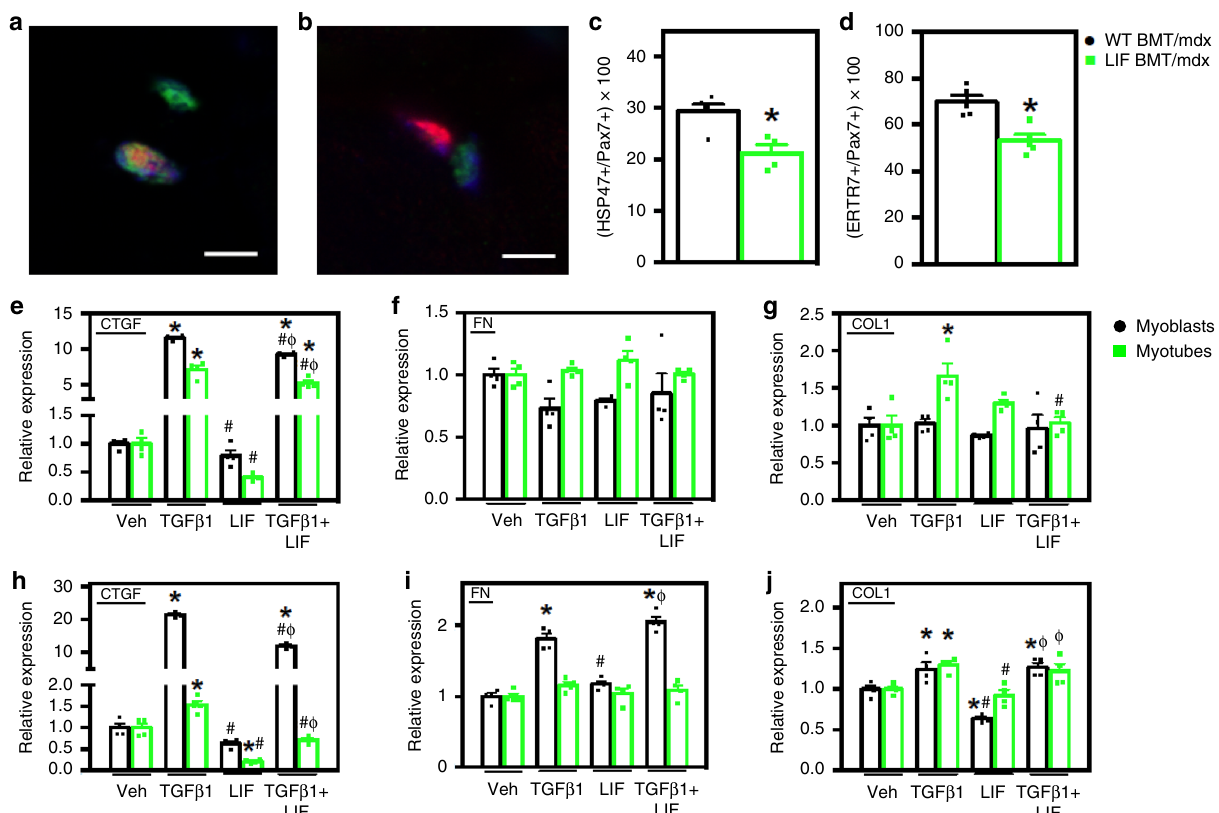
Fig. 7 LIF inhibits fi brogenesis and TGF β 1-induced Ctgf expression in muscle cells. a TA muscle sections were co-labeled with antibodies to Pax7 (red) and HSP47 (green) in WT BMT/ mdx ( a ) and LIF BMT/ mdx ( b ) recipients. Nuclei appear blue (DAPI). Bars = 5 μ m. c Fewer Pax7 + cells co-expressed HSP47 in LIF BMT/ mdx recipients (green symbols) compared to WT BMT/ mdx recipients (black symbols). d Muscle sections were also co-labeled with antibodies to Pax7 and fi brogenic marker Ertr7 to con fi rm that fewer Pax7 + cell acquired a fi brogenic phenotype in LIF BMT/ mdx recipients. N = 5 for each data set, except n = 4 for WT BMT/ mdx Pax7/HSP47 data set, * indicates signi fi cantly different from WT BMT/ mdx at P < 0.05. P- values based on two-tailed t- test. For all histograms in the fi gure, the bars indicate mean ± sem. e – j Myoblasts (black symbols) and myotubes (green symbols) were stimulated with LIF (10 ng/ml) and TGF β 1 (10 ng/ml) for 3- ( e – g ) or 24-h ( h – j ). e , h LIF inhibited TGF β 1-induced Ctgf mRNA in myoblasts and myotubes after 3- and 24-h of stimulation. LIF inhibited basal Ctgf expression in myotubes at 24 h ( h ). f , i LIF did not affect Fn1 expression in myoblasts or myotubes after 3- or 24-h. Additionally, LIF attenuated TGF β 1-induced Col1a1 expression in myotubes, but not myoblasts after 3 h of stimulation ( g ). Myoblasts stimulated with LIF for 24 h had reduced Col1a1 expression ( j ). N = 4 technical replicates per group. Signi fi cant fi ndings were veri fi ed with biological replicates of experiments from independent cultures. * Indicates signi fi cantly different from control, # indicates signi fi cantly different from TGF β 1-stimulated, and Φ indicates signi fi